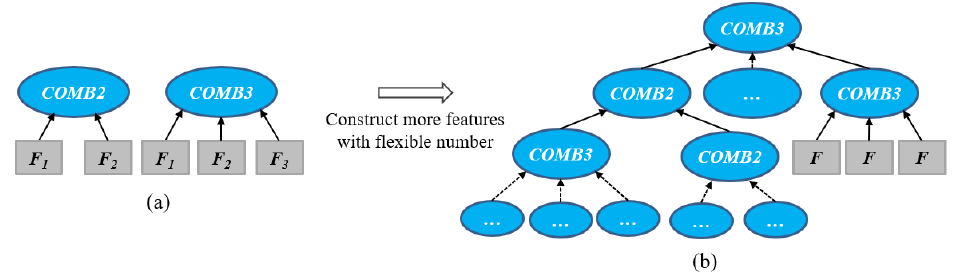
Figure 5. The new representation with the COMB2 and COMB3 functions produces a flexible/dynamic number of features by extending the depth of the tree. COMB2 and COMB3 are only used as the root node to produce two and three features ( a ); while they are used as the root and internal nodes to produce more features ( b ). F i denotes a subtree that produces a feature using functions (e.g., arithmetic operators) and terminals.